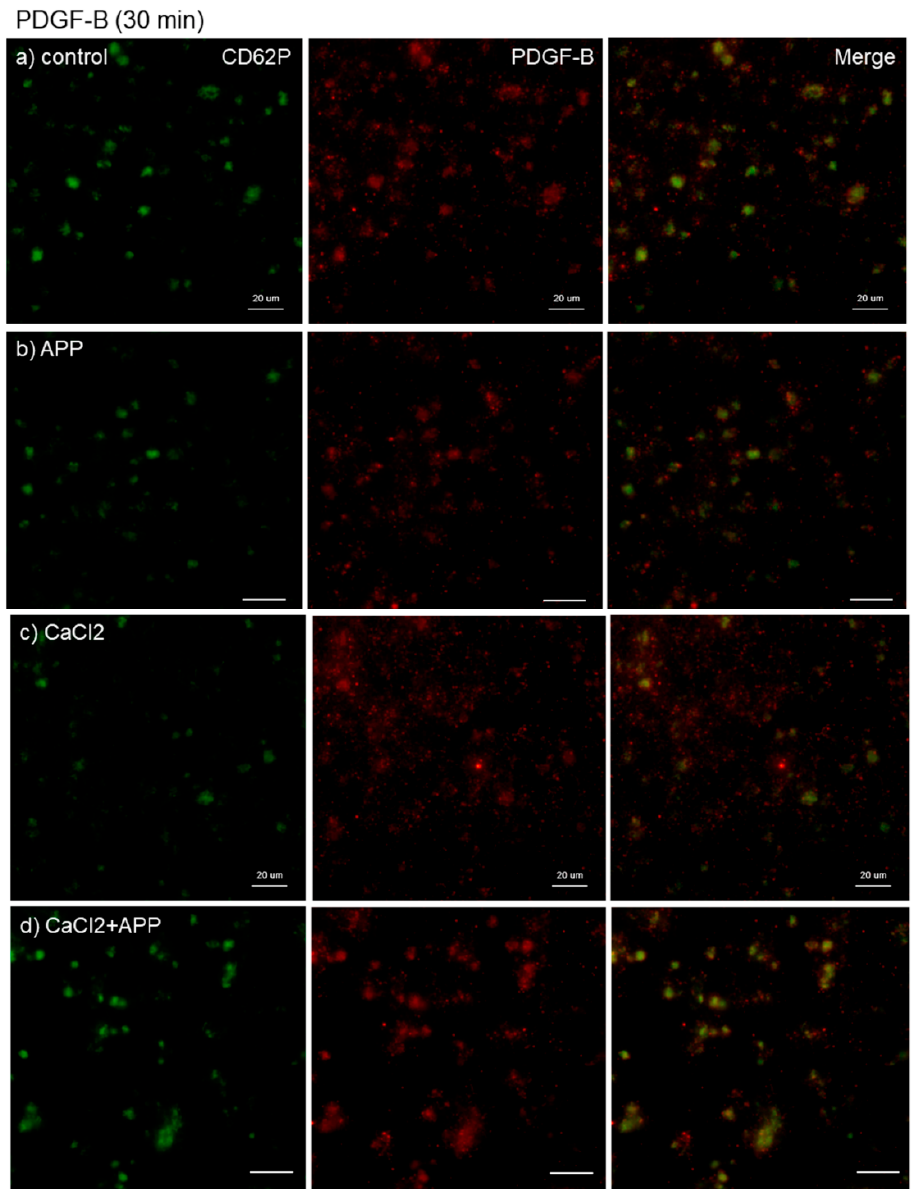
Figure 5. Effects of CaCl 2 and atmospheric pressure plasma (APP) treatments on PPAR γ distribution on cp -Ti plates at 30 min. Platelets were prepared, treated, and fixed for visualization (green: CD62P, red: PPAR γ ) as described in the legend of Figure 4. ( a ) Control platelets on non-treated cp -Ti plates, ( b ) control platelets on APP-treated cp -Ti plates, ( c ) CaCl 2 -stimulated platelets on non-treated cp -Ti plates, ( d ) CaCl 2 -stimulated platelets on APP-treated cp -Ti plates. Similar findings were obtained from the samples prepared from the other three donors. Bar = 10 μ m.